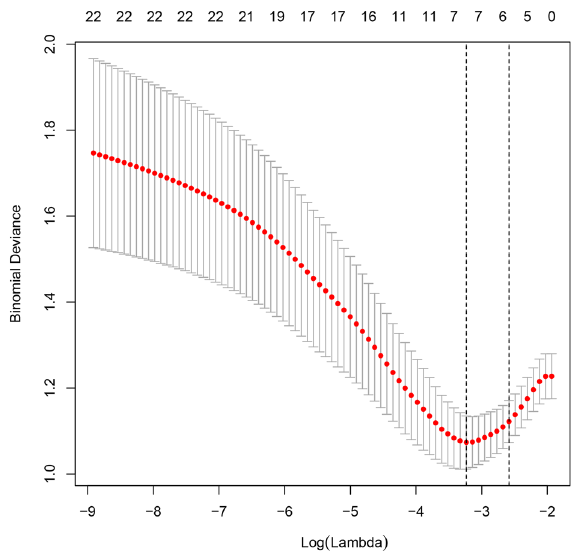
Figure 1. The LASSO model was constructed to select the optimal parameters (lambda) and the relationship graph between binomial deviance and log (lambda) was